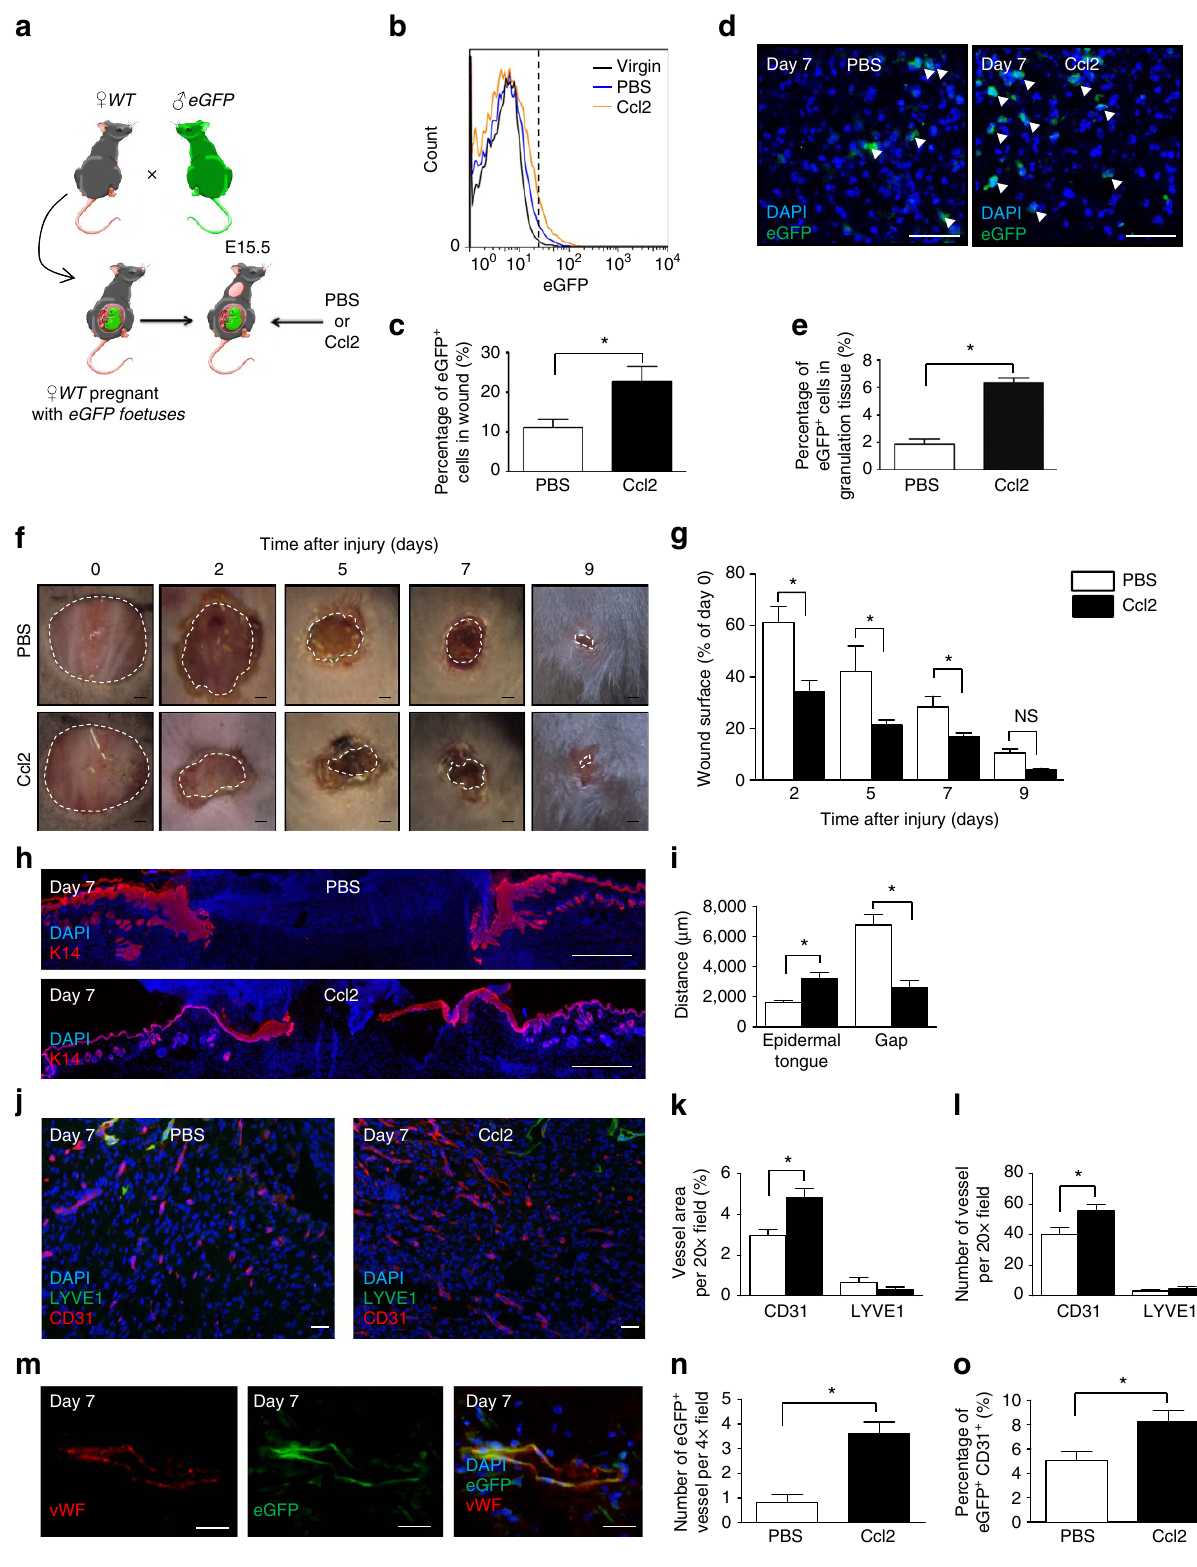
Ccl2 improves wound healing by enhancing neovascularization . receiving PBS (Fig. 2d,e). The enhanced mobilization of eGFP þ cells in wounds upon Ccl2 administration was also found at days We then analysed the effect of local Ccl2 treatment on maternal 3 and 5 (Supplementary Fig. 4). Therefore, Ccl2 is able to recruit wound healing. On days 3, 5 and 7 after wounding, the FMCs to wound sites throughout the cutaneous healing process. neo-epidermal tongue, which reflects the healing without NATURE COMMUNICATIONS|8:15463|DOI: